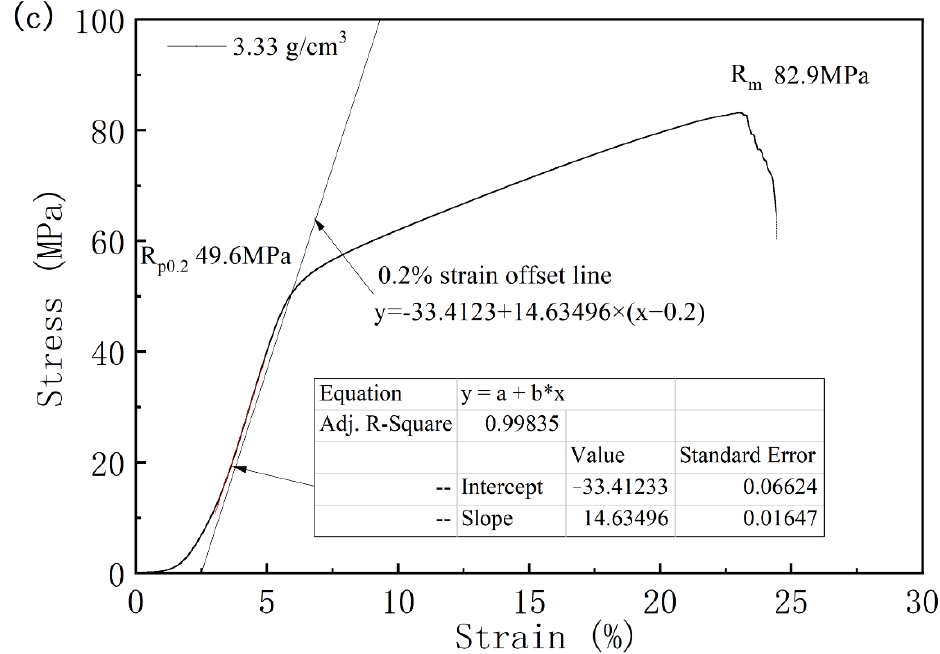
Figure 6. Tensile stress–strain curves of SSFs with different densities, ( a ) 3.64 g/cm 3 , ( b ) 3.40 g/cm 3 , ( c ) 3.33 g/cm 3 . Table 3. Comparison of tensile properties between SSFs and solid metal.